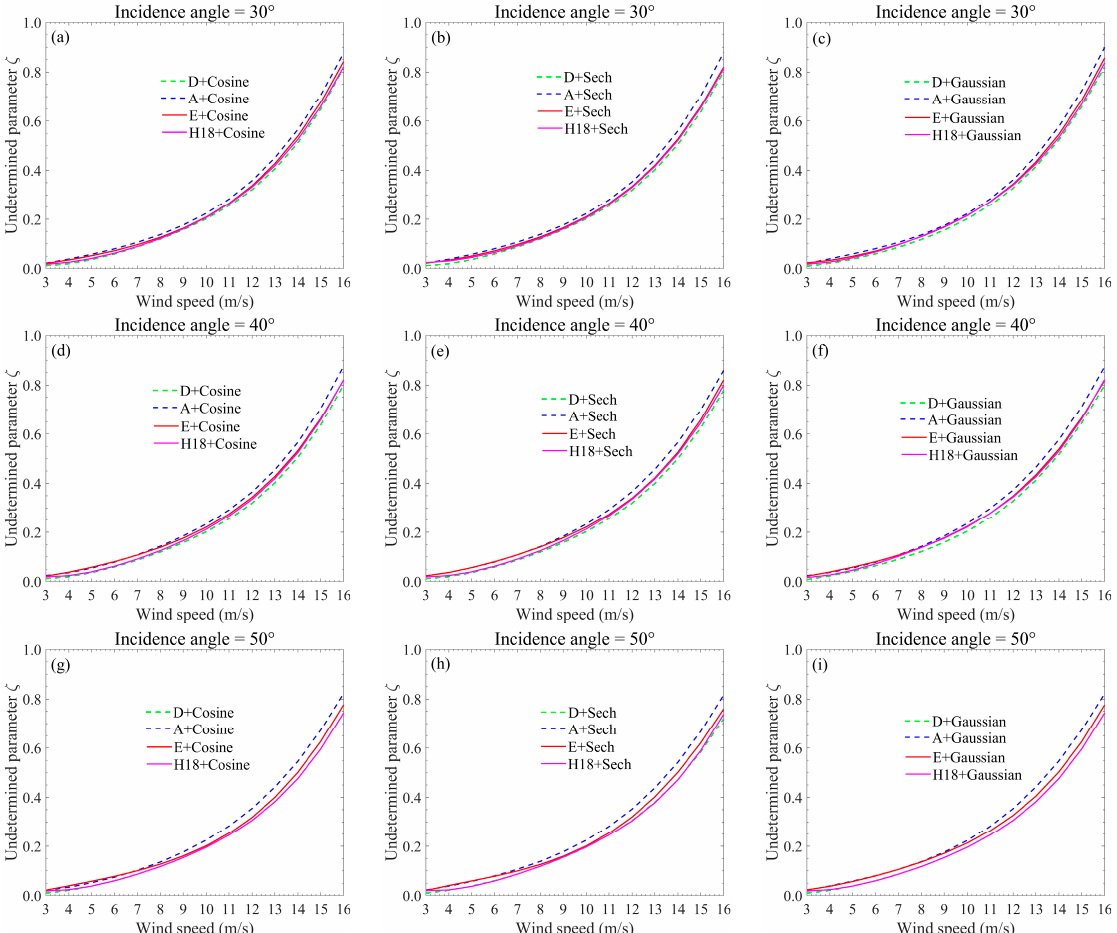
Figure 5. Estimations of the ζ parameter with the use of different directional wave spectra of D + Cosine, D + Sech, D + Gaussian, A + Cosine, A + Sech, A + Gaussian, E + Cosine, E + Sech, E + Gaussian, H18 + Cosine, H18 + Sech, and H18 + Gaussian as functions of wind speed ( a – c ) at incidence angle of 30 ◦ , ( d – f ) at incidence angle of 40 ◦ , ( g – i ) at incidence angle of 50 ◦ .